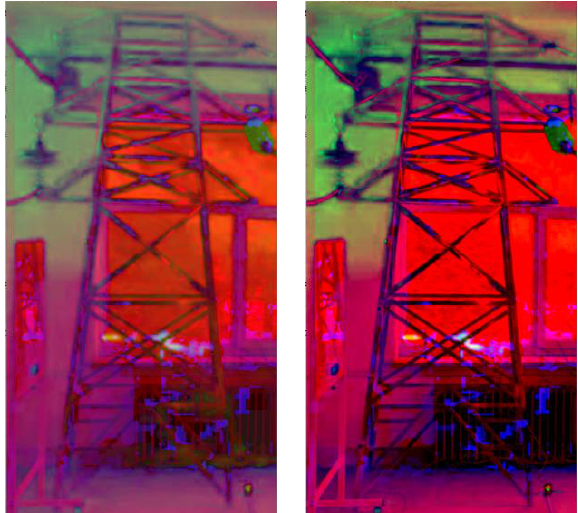
Figure 2. RGB images converted to HSV images.